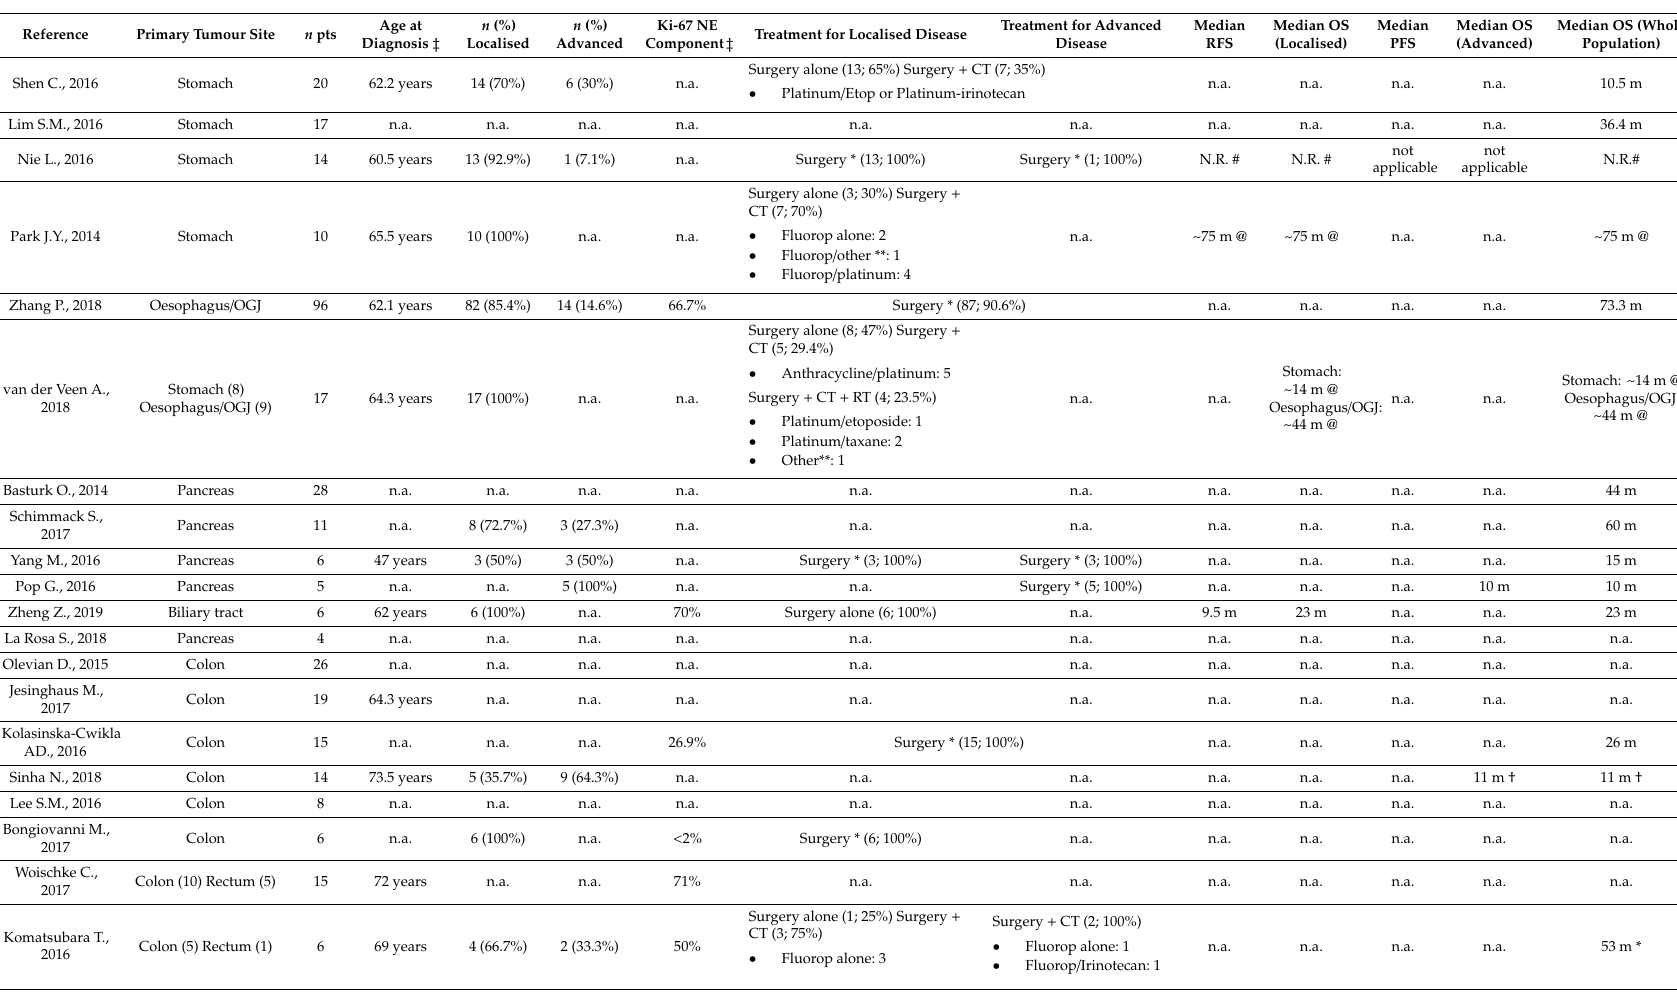
Table 3. Treatment modalities and survival outcomes of patients with a diagnosis of mixed neuroendocrine non-neuroendocrine neoplasm in retrospective studies.